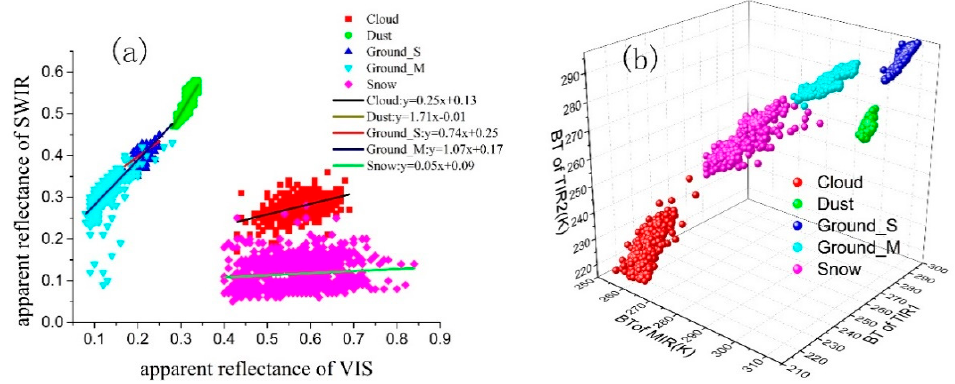
Figure 3. Clustering characteristics of five different wavelength regions representing five different underlying surfaces: ( a ) the apparent reflectance of VIS (0.65 μ m) and SWIR (1.6 μ m); and ( b ) brightness temperature of MIR (3.9 μ m) and TIR1 (10.8 μ m).